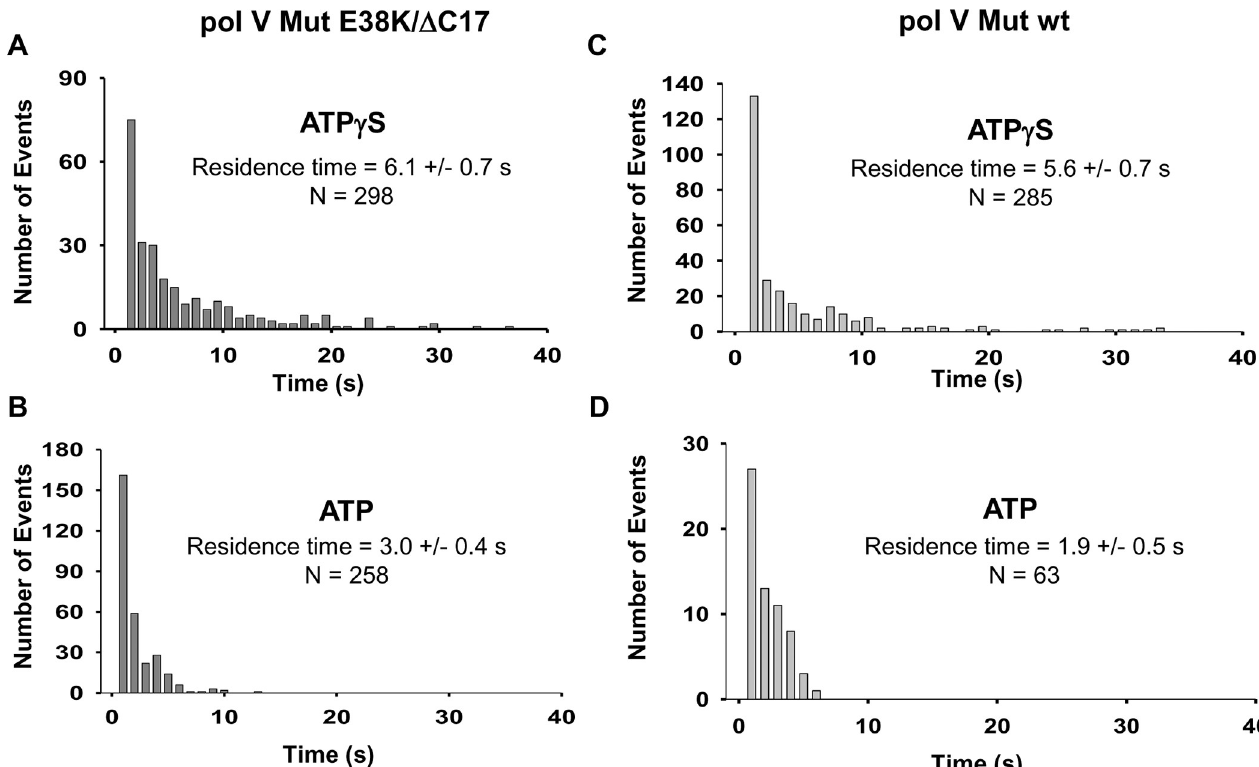
Fig 9. Histograms for DNA binding residence times of activated pol V Mut. Histograms representing DNA residence times of ATP γ S/ATP-activated 1nM pol V Mut E38K/ Δ C17 (A-B) and 5 nM pol V Mut wt (C-D). Pol V Mut residence times were calculated by fitting the data to a single exponential decay